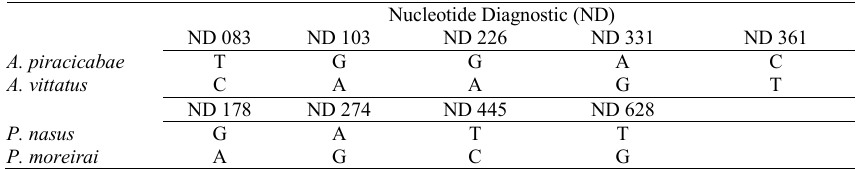
Table 3. Analysis by nucleotide diagnostic (ND) for the pair of species with divergence lower less than